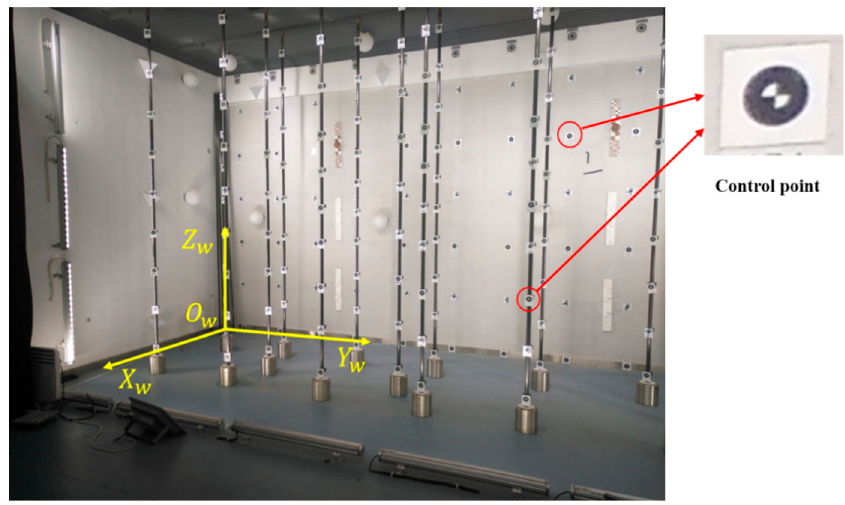
Figure 1. Photogrammetric control field.